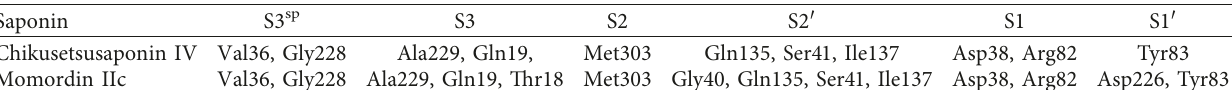
Table 3: Residues of amino acids with hydrophobic interactions in the active pockets of renin.